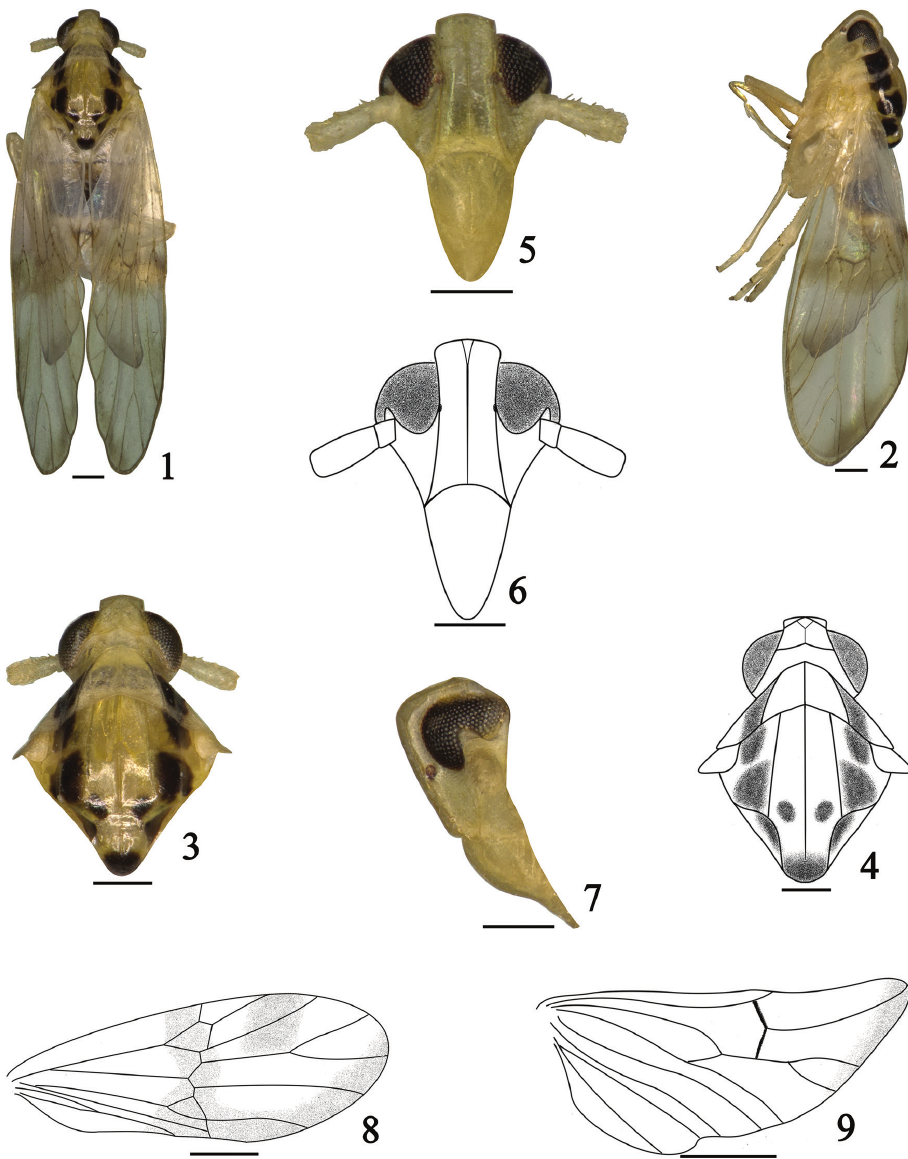
Figures 1–9. Bambusiphaga yingjiangensis sp. n. 1 Male habitus, dorsal view 2 Same, lateral view 3–4 Head and thorax, dorsal view 5 – 6 Face 7 Frons and clypeus, lateral view 8 Forewing 9 Hindwing. Scale bars 1 – 7 0.2 mm; 8 – 9 0.5 mm.